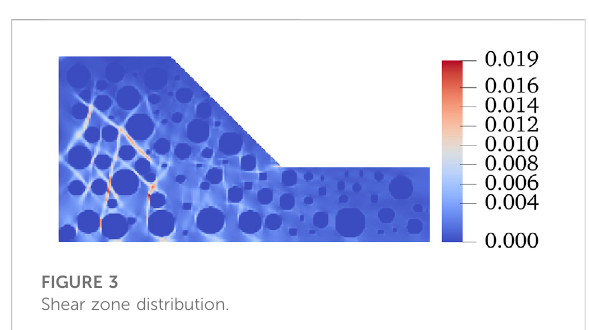
TABLE 1 Mechanical parameters of the SRM slope.